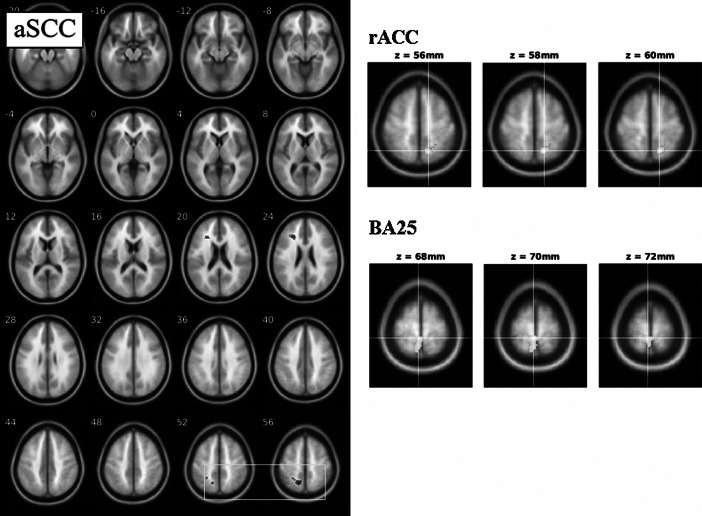
Anterior subcallosal cingulate (aSCC), rostral anterior cingulate (rACC), and BA25 resting-state functional connectivity pre- versus post-differences following cognitive behavioral therapy in major depressive disorder (N = 19 participants). For aSCC, regions that decreased include precuneus (box); for rACC and BA25, regions that decreased include paracentral lobule (right panels). For display purposes, maps are thresholded at p < 0.001, k > 40.